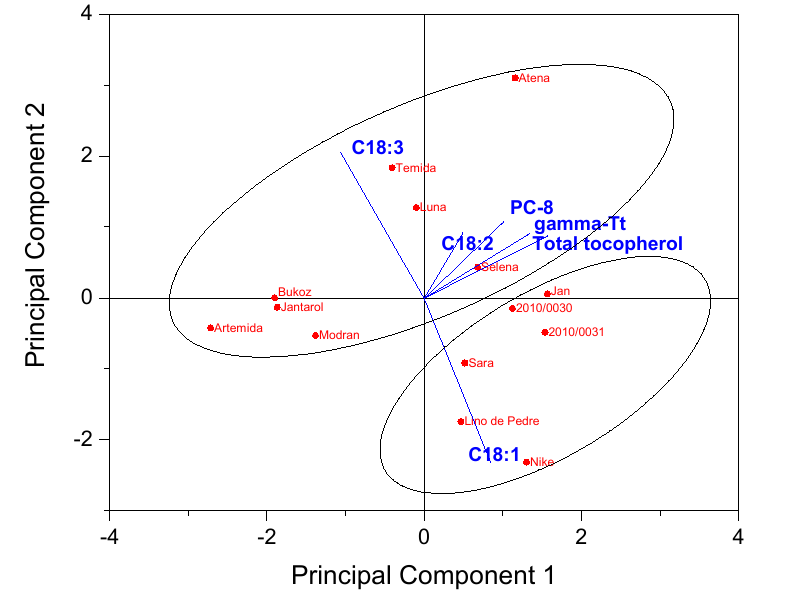
Fig. 5 Biplot representation of PCA for local varieties of flax (Group